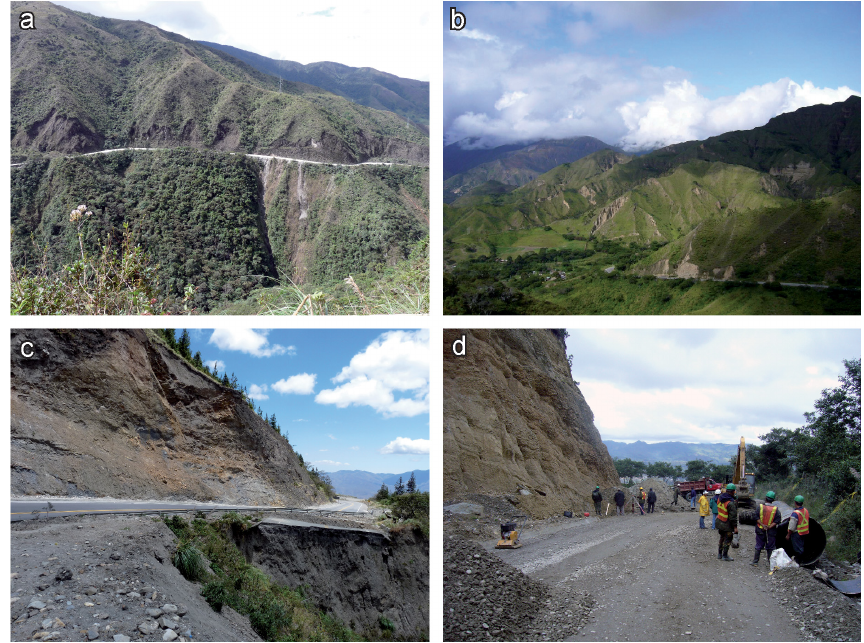
Figure 2. Landslides occurring along the investigated highways. (a) Typical landslides of the wet metamorphic part of the study area in the east. (b) Typical landslides of the semi-arid, conglomeratic part of the study area in the west. (c) Highway destroyed by landsliding. (d) A highway is cleared from a recent landslide